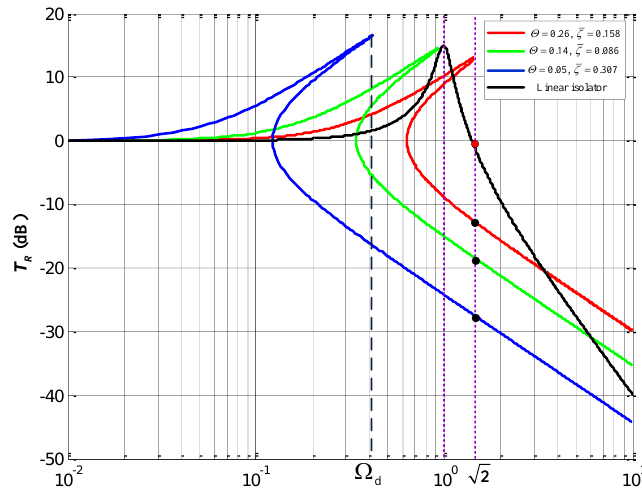
Figure 8. The influence of input disturbance amplitude on transmissibility.